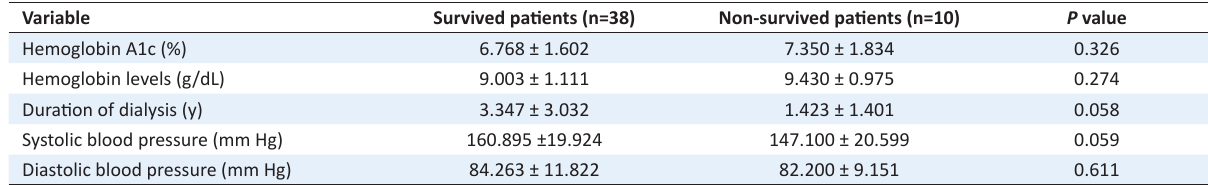
Table 2. Comparison of parameters between survived and non-survived patients by independent samples t test Variable